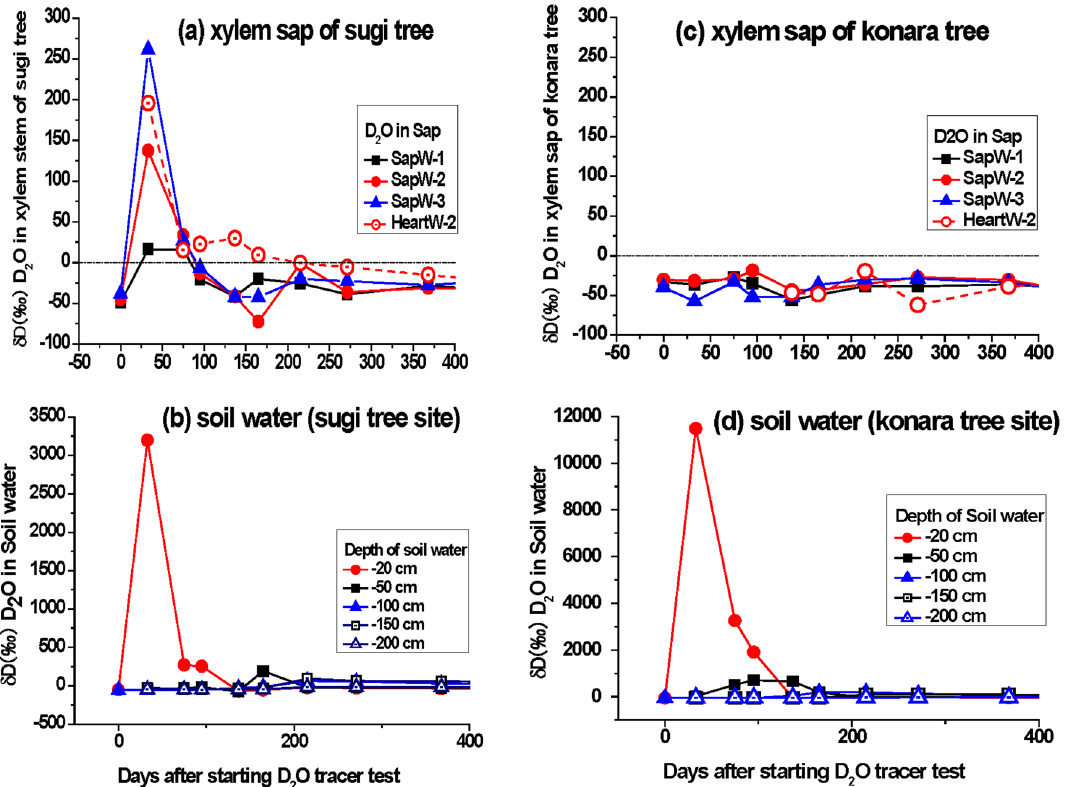
Figure 1. Changes in δD values (‰) in the soil water, sapwood sap, and heartwood sap of sugi and konara trees over 400 days after the start of the D 2 O tracer test on 12 March 2015 in the Utsunomiya University Forest. ( a ) δD values (‰) of sugi xylem sap (sapwood of trees S1, S2, and S3, and heartwood sap of tree S2), ( b ) δD values (‰) of soil water (at depths of 20, 50, 100, 150, and 200 cm) at the sugi site, ( c ) δD values (‰) of konara xylem sap (sapwood of trees K1, K2, and K3 and heartwood sap of tree K2), ( d ) δD values (‰) of soil water (at depths of 20, 50, 100, 150, and 200 cm) at the konara site. Note that the y -axis scales differ greatly in ( b ) and ( d